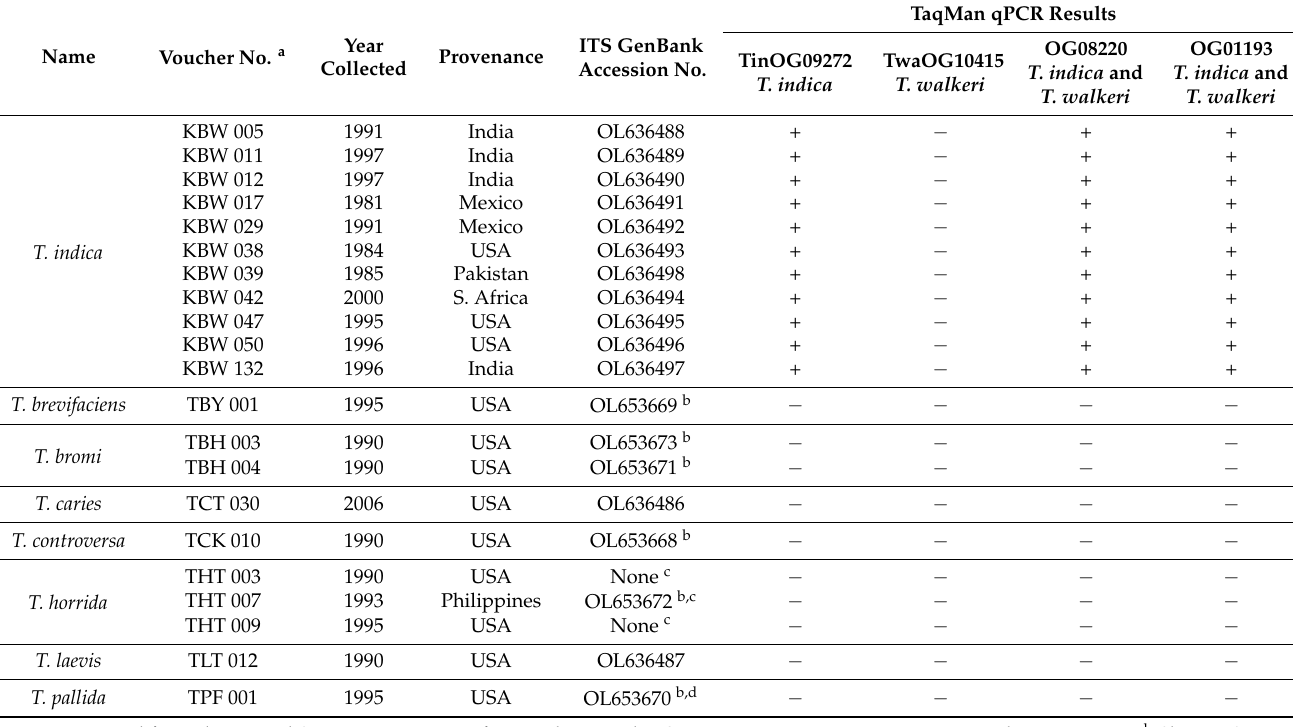
Table 3. Voucher numbers, provenance, year collected, ITS GenBank accession numbers and assay validation results for the field-collected environmental Tilletia specimens used in this